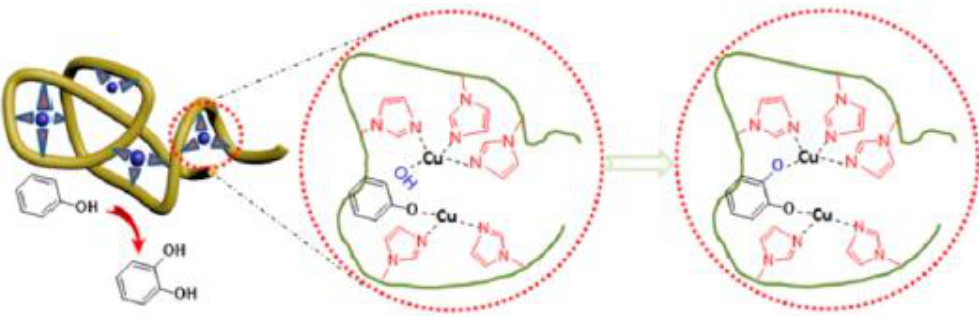
Figure 13. Schematic illustration of Cu-containing SCNPs employed as artificial metalloenzymes for hydroxylation reactions of phenol to catechol in water showing high selectivity (>80%) and turnover frequency (TOF) (872 h − 1 ) (reprinted from [31] with permission, Copyright American Chemical Society, 2014).